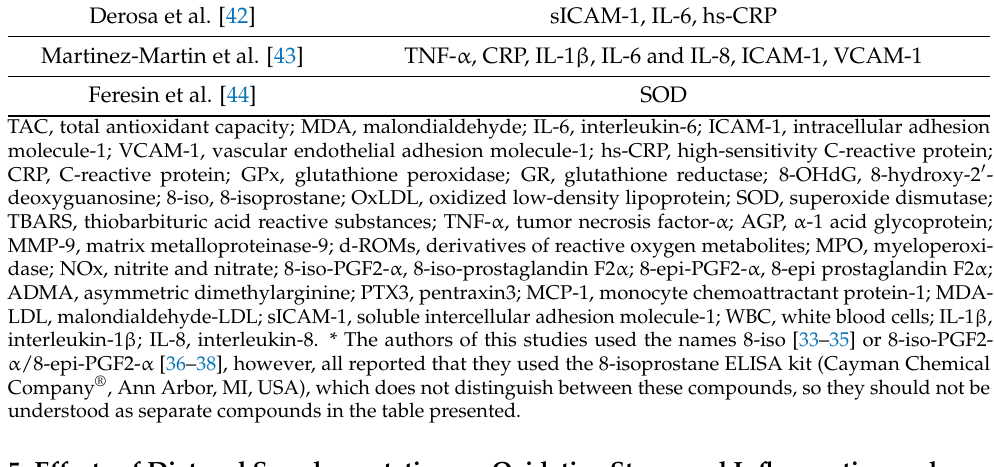
Table 2. Cont. Study